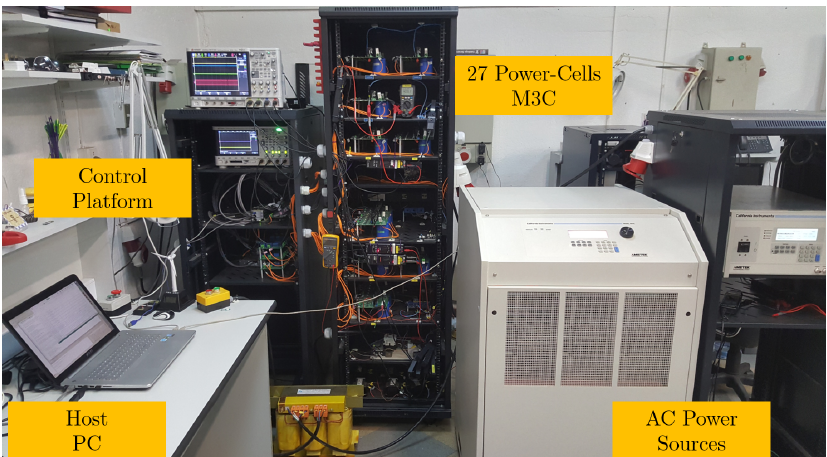
Figure 11. Experimental system utilised to test the performance of a WEC-based prototype for LVRT control. Adapted from [27,87,88].